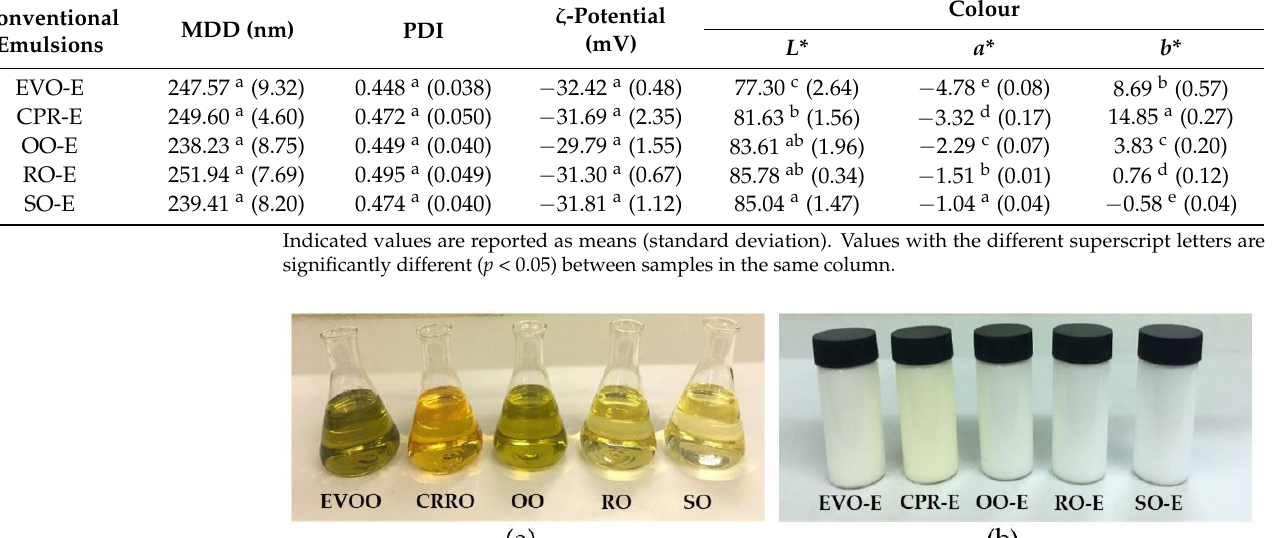
Table 1. Mean droplet diameter (MDD), polydispersity index (PDI), ζ-potential and colour of conventional emulsions (-E) prepared with the different oils: extra virgin olive oil (EVO-E), cold-